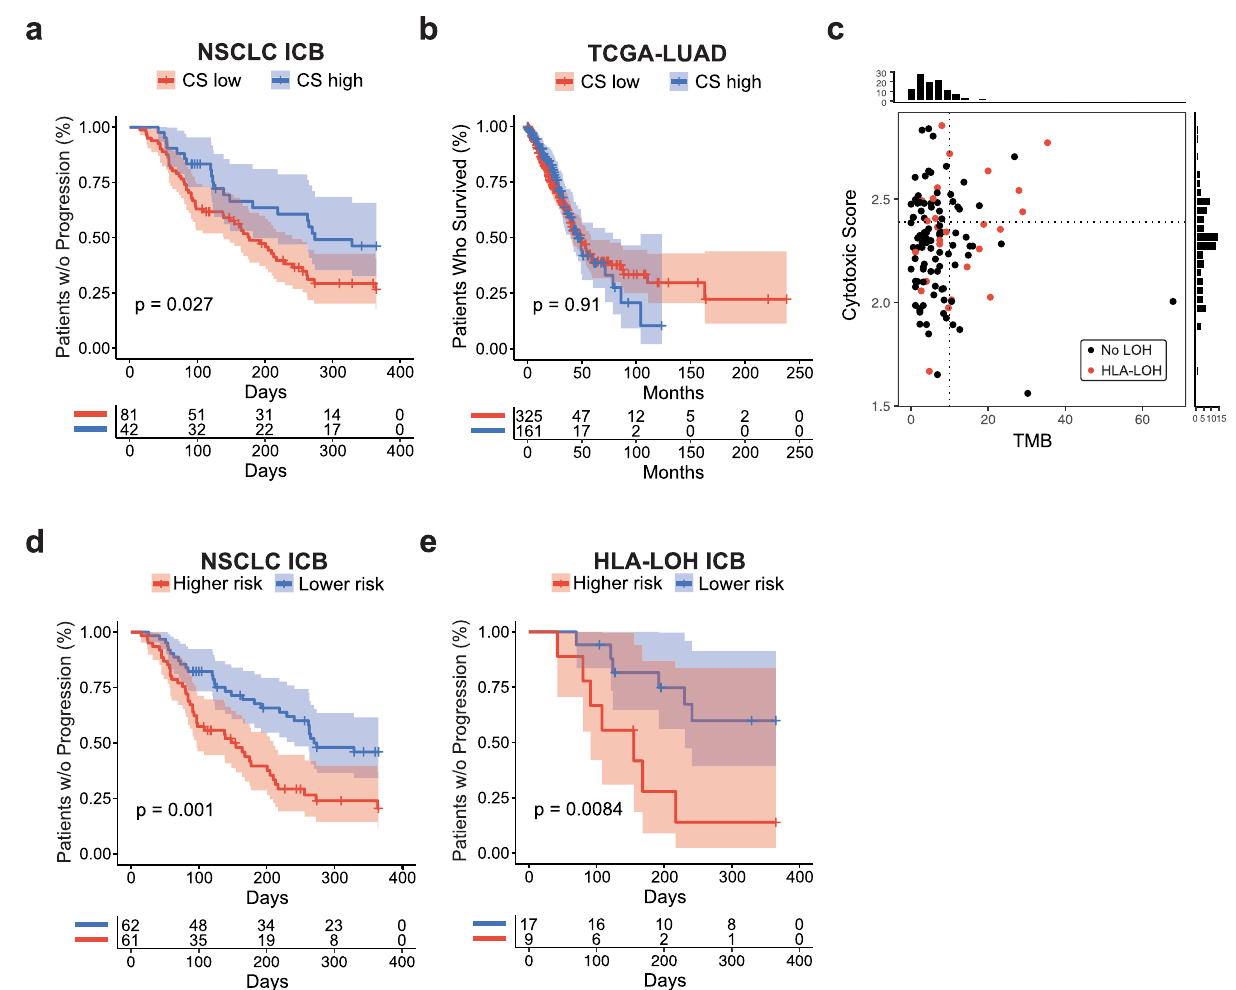
Fig. 5 Cytotoxic gene signature is associated with ICB response in NSCLC. a Kaplan – Meier plots showing time to progression strati fi ed by cytotoxic score (CS) status in the Tempus NSCLC ICB cohort ( n = 123, HR = 0.56, p = 0.029, log rank), and b the TCGA-LUAD NSCLC cohort ( n = 486, HR = 1.00, p = 1.0, log rank). c Correlation of TMB and CS in the NSCLC ICB cohort ( n = 123, R = − 0.0098, unadjusted p = 0.91, Pearson correlation test). d Kaplan – Meier plot showing time to progression on ICB therapy, strati fi ed by multimodal score (MM) status in the Tempus NSCLC ICB cohort ( n = 123, HR = 1.94, p = 0.005, log rank) and e the HLA-I-de fi cient subgroup ( n = 26, HR = 3.59, p = 0.017, log rank). Source data are provided as a Source Data fi